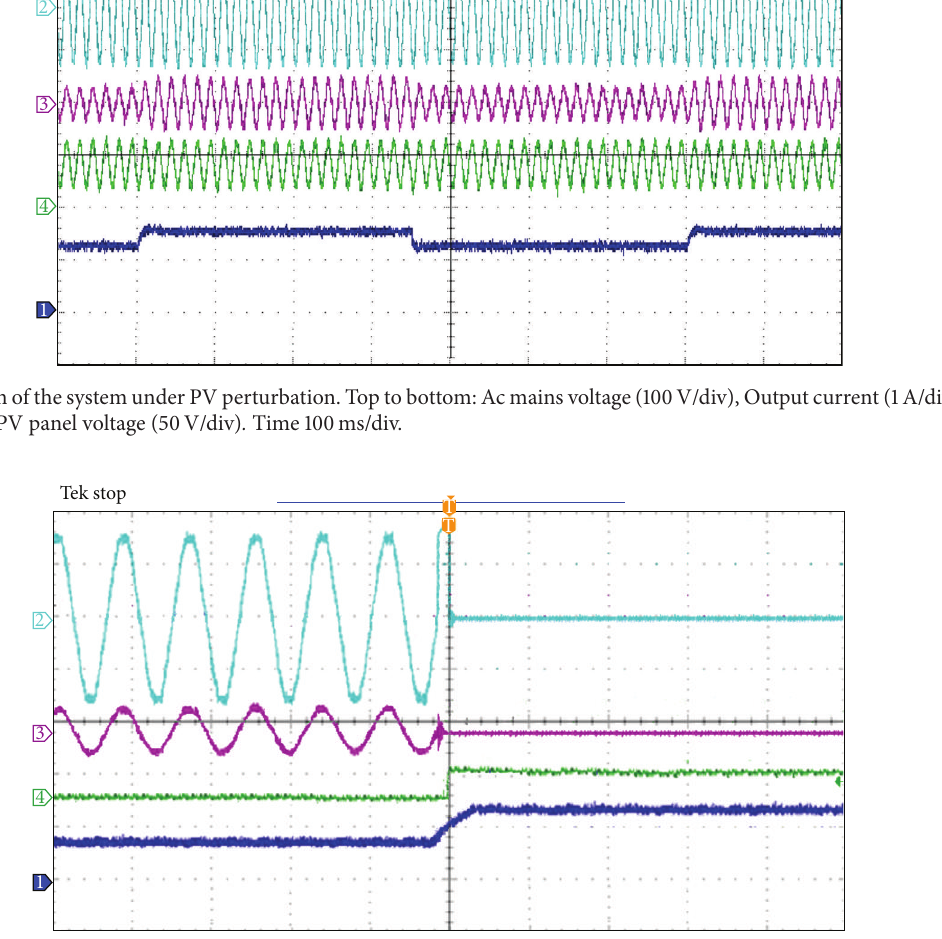
Figure 16: Operation of the system under grid disconnection. Top to down: Capacitor 𝐶 𝑜 voltage (100V/div), Output current (1A/div), grid disconnection detector by using overvoltage detector (5V/div), and Capacitor voltage 𝐶 𝑟 (100V/div) . Time